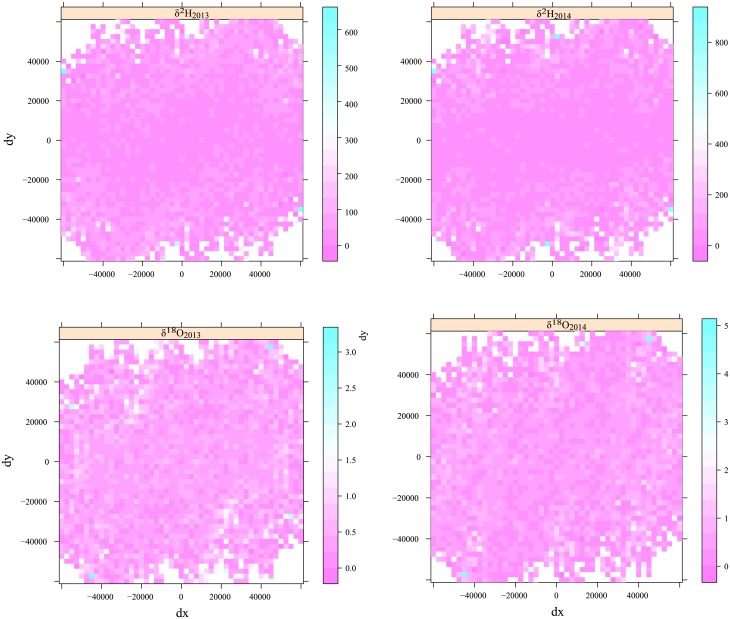
Anisotropy maps of δ18O and δ2H plotted for 2013 and 2014.